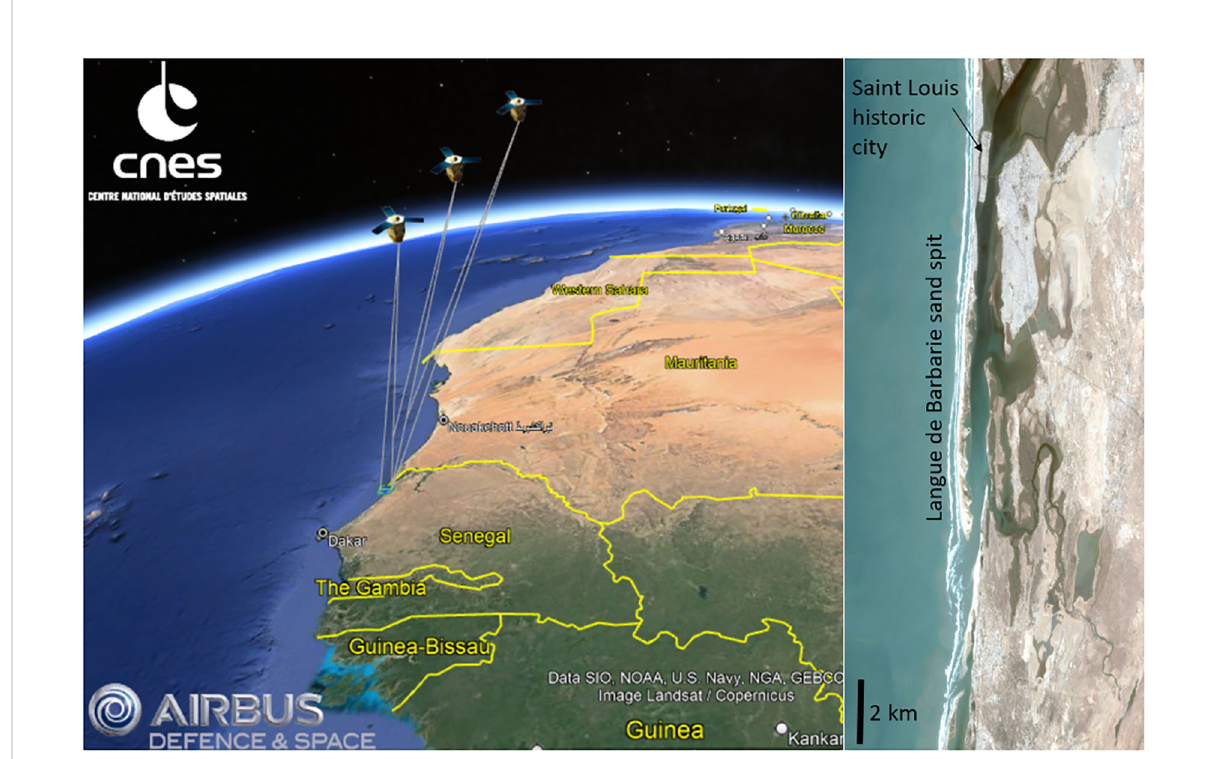
FIGURE 1 Location of the study area and satellite images acquisition. (Left) Pleaides satellite (CNES/Airbus) tri-stereo acquisition (made using Google Earth). (Right) North-oriented Pleiades satellite image of Saint Louis